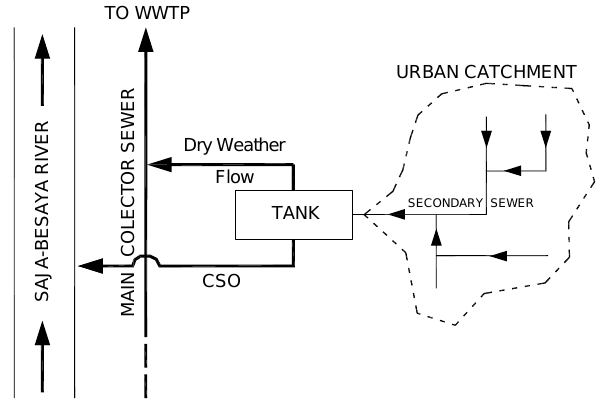
Fig. 2. Conceptual scheme of the modelled urban drainage